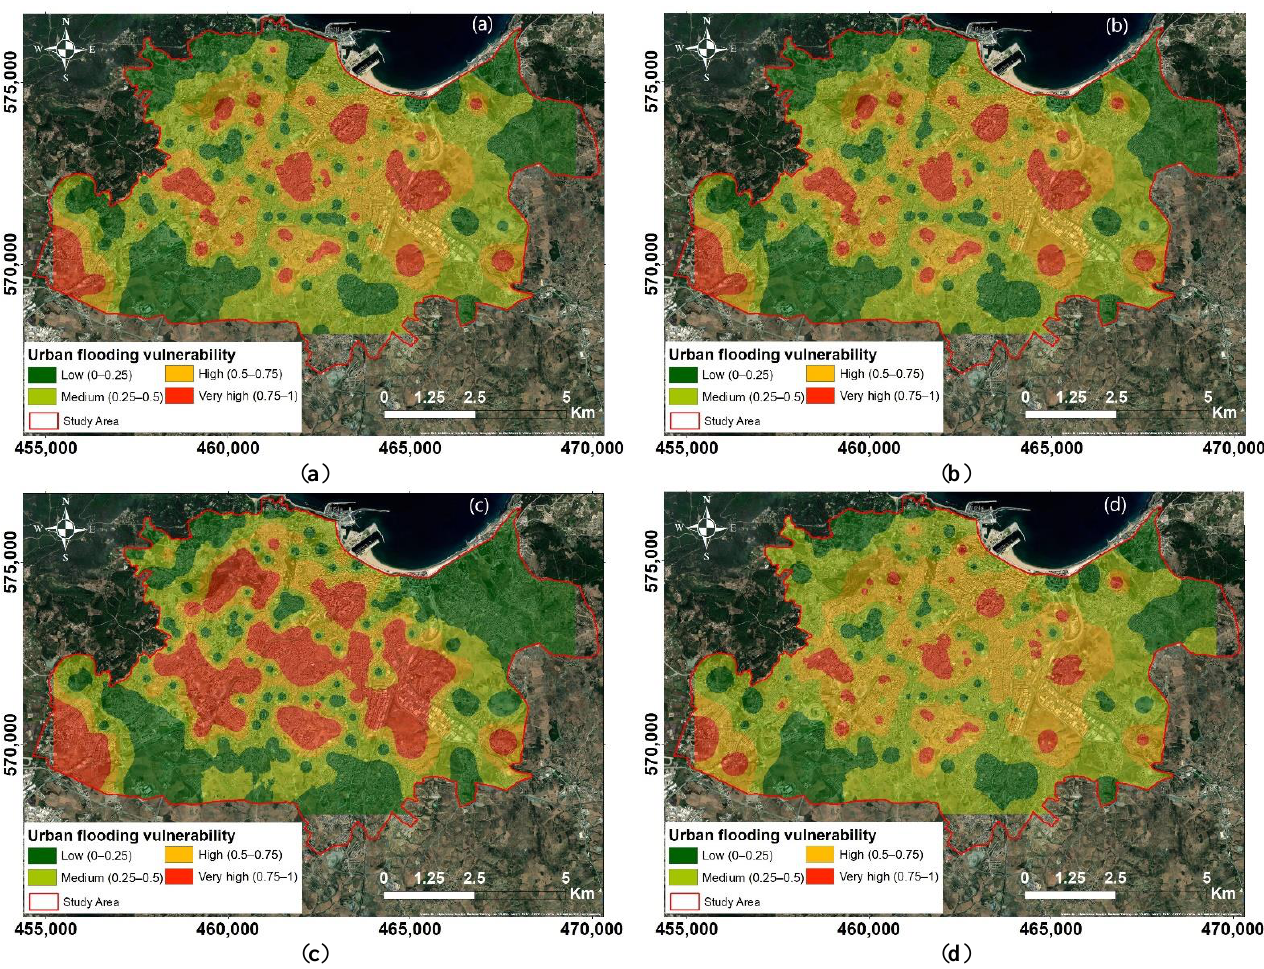
Figure 8. Urban flooding vulnerability map obtained from ( a ) linear discriminant analysis (LDA); ( b ) logistic regression (LR); ( c ) classification and regression tree (CART); ( d ) Support vector machine